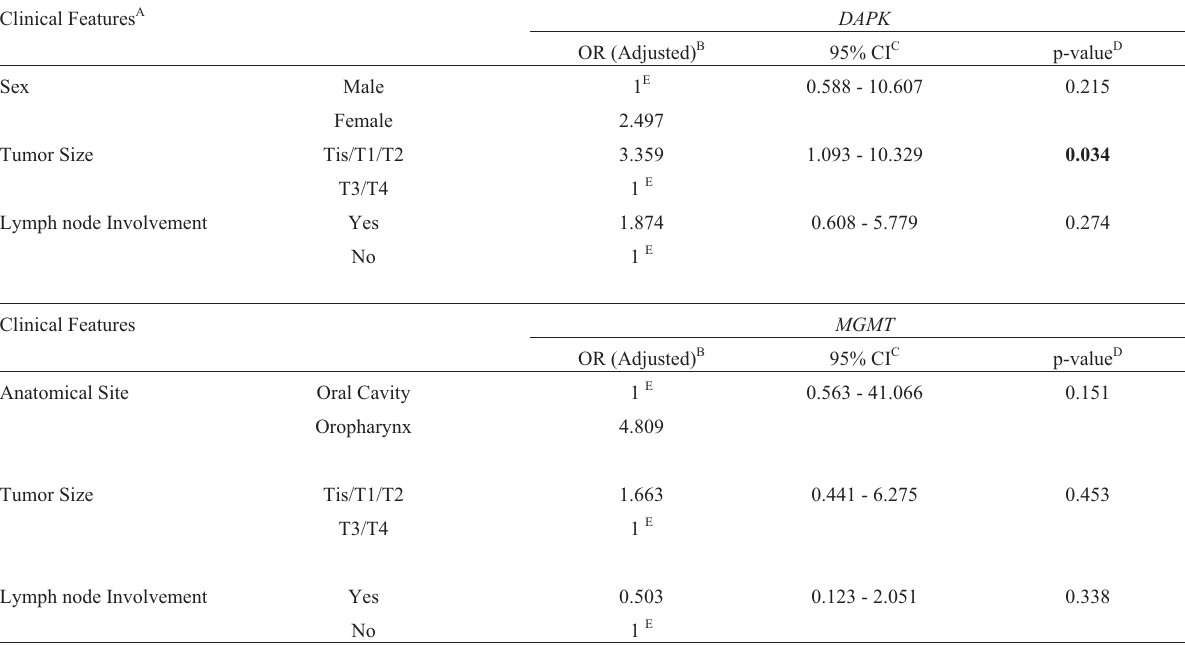
Table 3 - Multiple logistic regression of clinical features and DAPK and MGMT